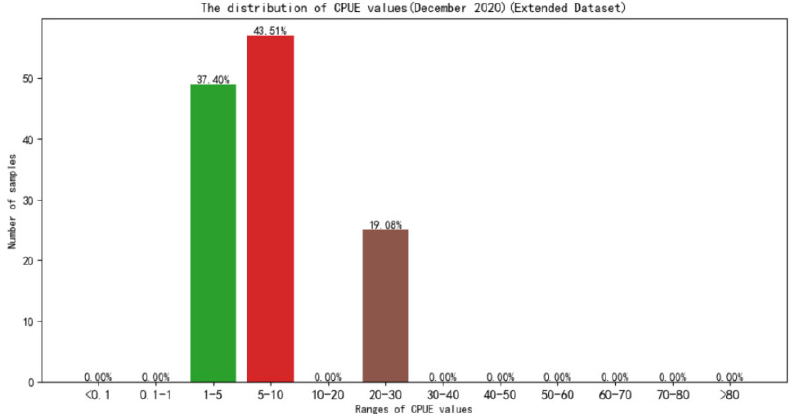
Figure 15. The distribution of CPUE values of samples in test datasets in December 2020.